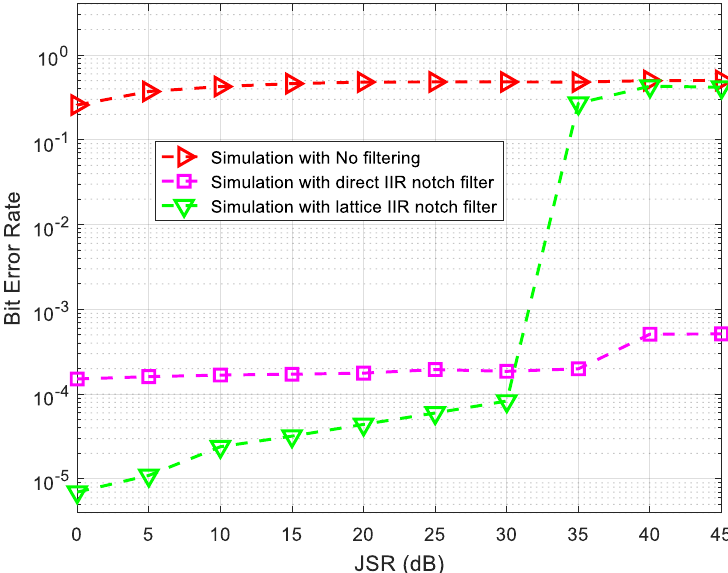
Figure 21. BER vs. JSR, with E b / N o = 20 dB.